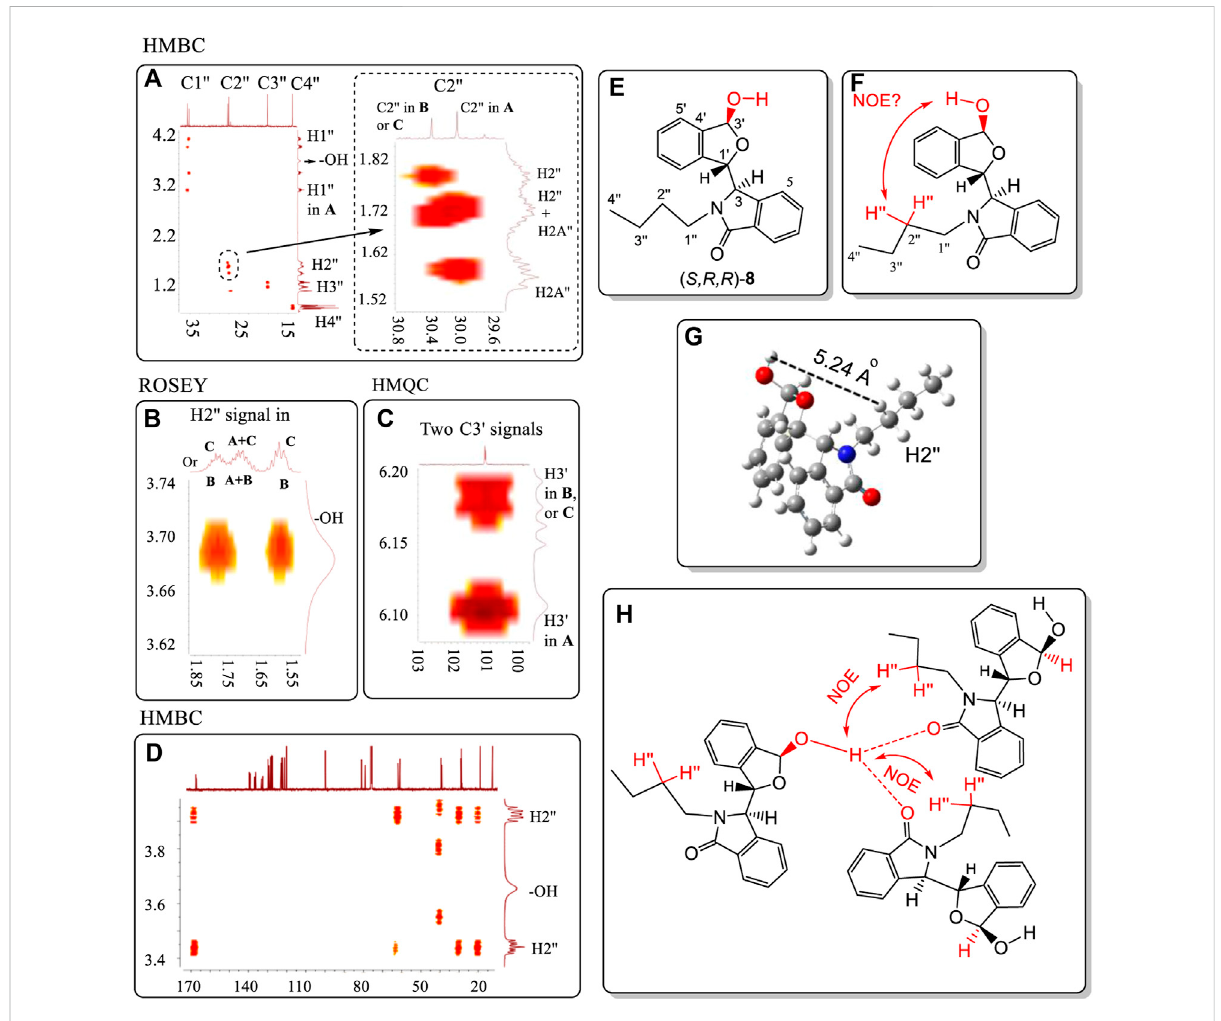
FIGURE 9 (A) HMBC correlations of C1 ″ to C4 ″ on the N substituent containing the corresponding H1 ″ to H4 ″ atoms in two geometries of 8 . (B) ROESY correlationofthehydroxylprotonwiththeH2 ″ atomsofthe N - n Bugroupof 8 . (C) HMQCcorrelationsofC3 ′ withH3 ′ inthetwodistinctgeometries of 8 . (D) HMBC correlations of the – OH proton with all carbons of 8 . (E) Numbering of structure 8 . (F) No observed intramolecular NOE interaction can occur between the H3 ′ and H2 ″ of n Bu and the – OH within the same molecule of 8 . (G) The distance between the – OH and H2 ″ is over 5.2 Å. (H) The strong intermolecular NOE between the – OH proton and n Bu H2 ″ atoms in two different molecules of 8 was observed (Figure 9B). However,thisaggregatestructurewillleadtotheratioamongthethreemoleculesof 8